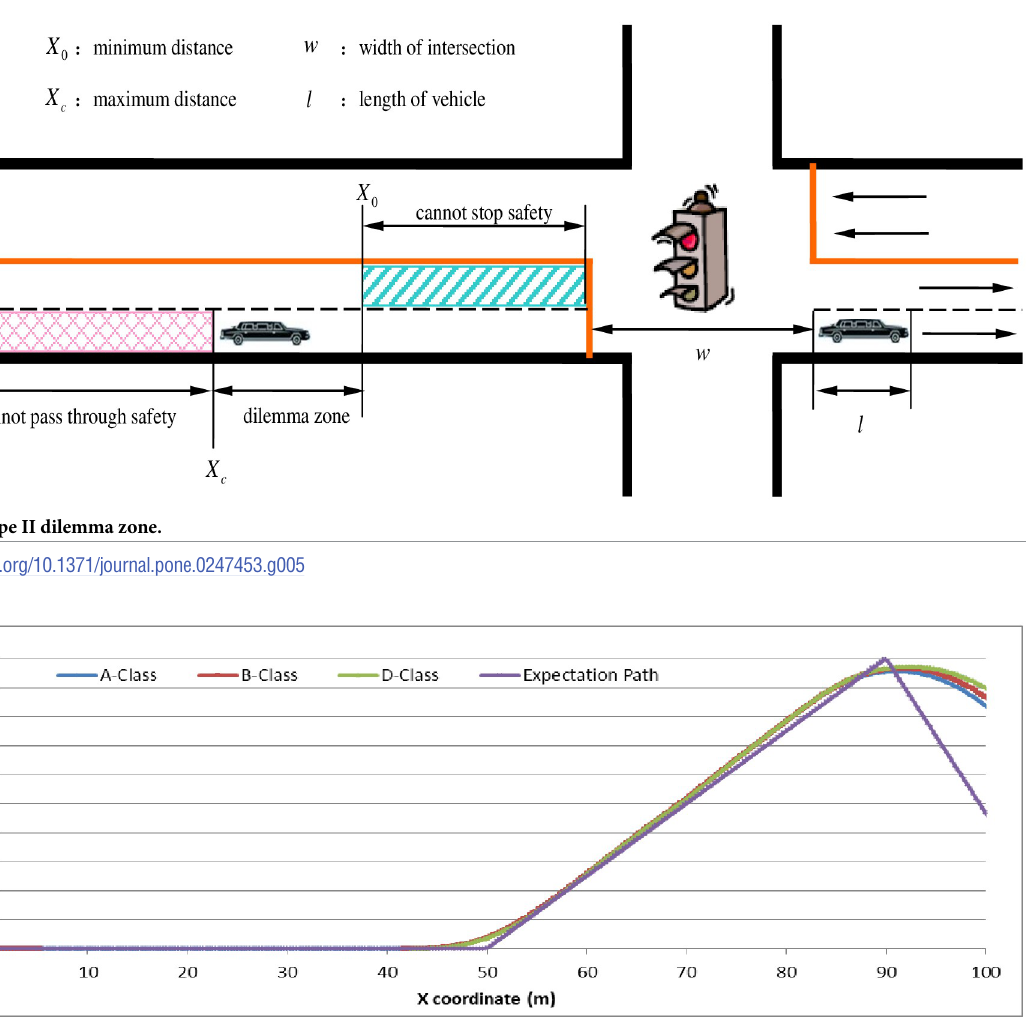
Fig 6. The vehicle driving trajectory of different vehicle models in N E = 10 (Group 1).